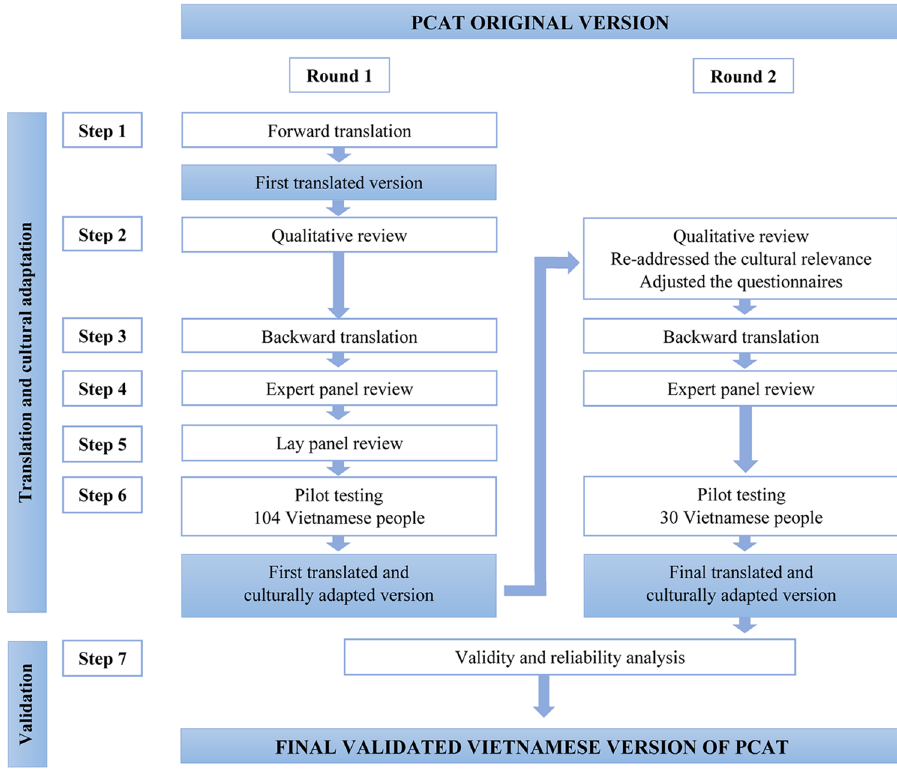
Fig 1. PCAT translation and validation